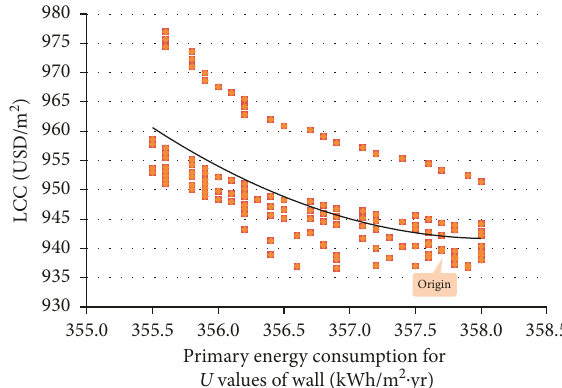
Figure 4: LCC according to the U values of the walls.